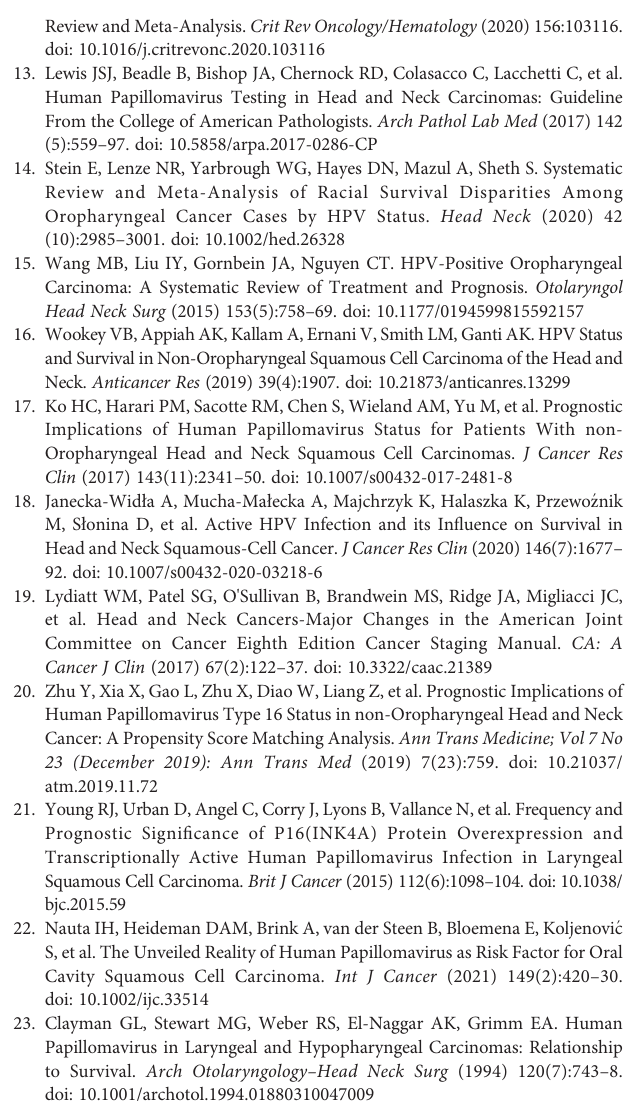
Supplementary Figure 1 | ROC curves depicting predictive performance of the survival nomograms in the validation cohorts. (A, B) ROC curves for 3-year and 5-year OS of OPC patients in the validation cohort; (C, D) ROC curves for 3-year and 5-year OS of HPC patients in the validation cohort. ROC: receiver-operating characteristic; OS: overall survival; FP: false positive; TP: true positive; OPC: oropharyngeal carcinoma; HPC: hypopharyngeal carcinoma. Supplementary Figure 2 | The calibration curves for predicting OS of OPC and HPC patients in the validation cohorts. (A, B) Calibration curves for 3-year and 5-year OS of OPC patients in the validation cohort; (C, D) calibration curves for 3- year and 5-year OS of HPC patients in the validation cohort. OS: overall